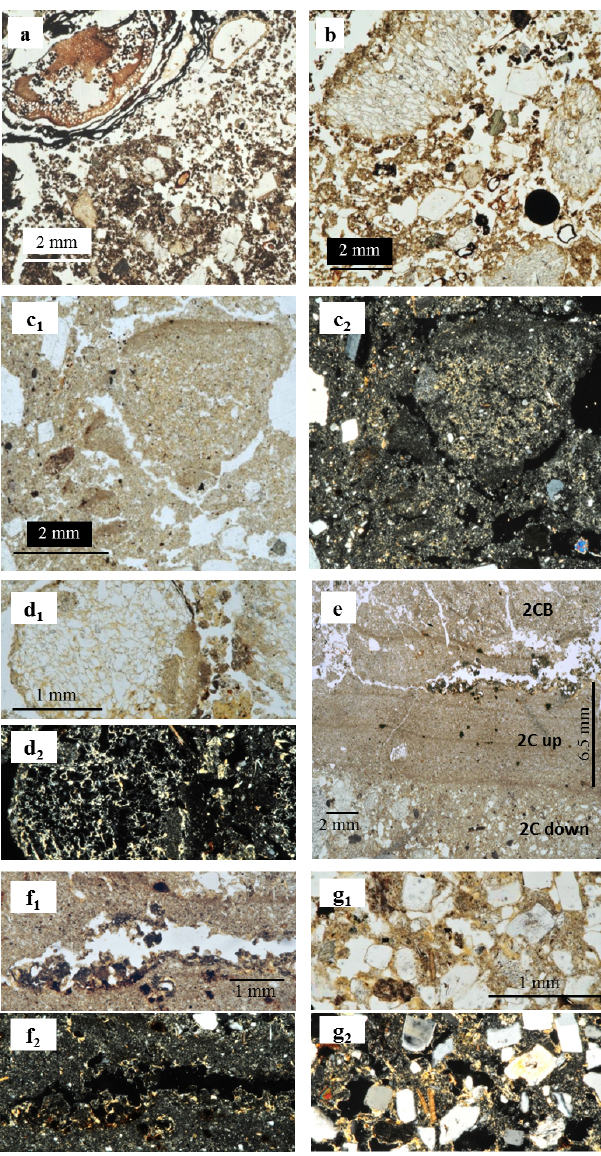
Figure 4. Optical microscopy: (a) very fine granular structure, pres- ence of living roots and decomposed organic residues in the A hori- zon; (b) granular structure, showing very abundant (from 25 to 50%) poorly weathered pumice fragments, enveloped by silty–fine sandy brown material, in the Bw horizon; (c) angular to sub-angular aggregates, pseudo-stratified by finer brownish and coarser materi- als and chaotically immersed in the soil matrix of the 2CB horizon (c 1 and c 2 in PPL and XPL, respectively); (d) weathering and neo- genetic clays in a pumice and clay coating fragments in a root pore (d 1 and d 2 in PPL and XPL, respectively); (e) transition from 2CB towards the finely stratified upper part of 2C; (f) root pore at the 2CB–2C boundary, in which anisotropic clay coatings and frequent Fe–Mn segregations coat the walls (f 1 and f 2 in PPL and XPL, re- spectively); (g) lower, coarser part of 2C, which has a mineral gran- ular structure with pores emptied by clay infillings (g 1 and g 2 in PPL and XPL,